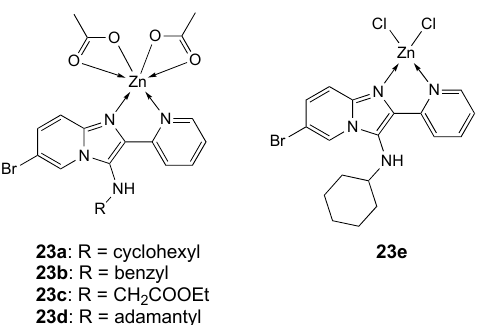
Figure 12. Structure of the zinc complexes 22a , 22b .